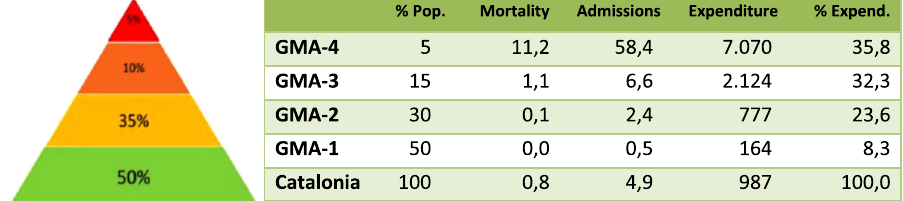
Fig. 5 Strati fi cation of the Catalan population (2014) using the GMA. Previously published in Dueñas-Espín I et al., BMJ Open. 2016 Apr 15;6(4) as part of the online supplementary material (Supplementary Figure 2S). The third and fourth columns depict rates of mortality and hospital admissions, respectively. The fi fth column indicates the cost per inhabitant per year expressed in € and the last column refers the percentage of total healthcare expenditure by risk strata. It is of note that the closer the patient is to the tip of the pyramid, the higher are mortality, risk of hospital admission, and healthcare expenses. Green color ( bottom ) indicates healthy status, whereas red ( tip ) corresponds to maximum risk of admissions and highest mortality